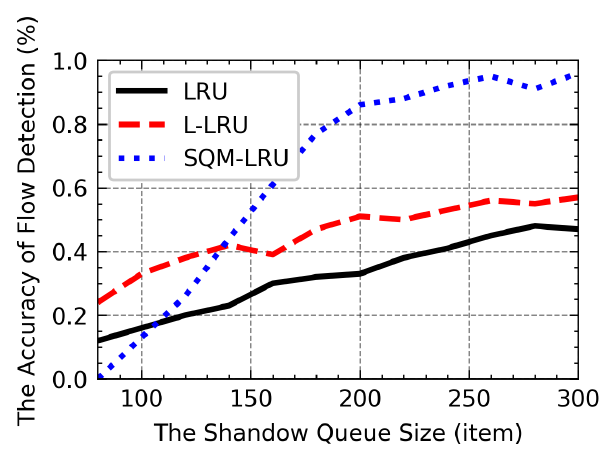
Figure 18. The influence of SQ length on Acc.